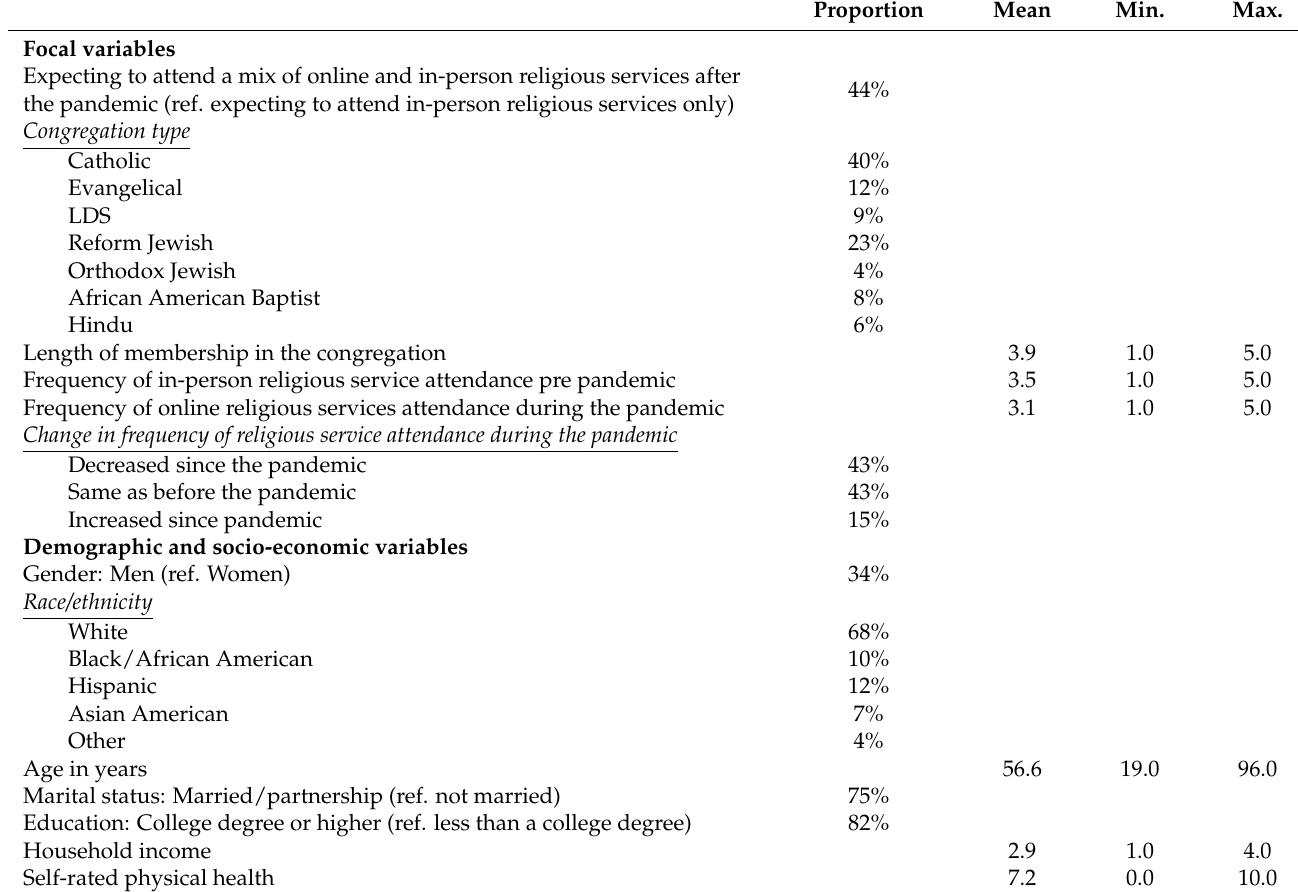
Table 1. Descriptive statistics of the analytic sample (n = 1116). Proportion Mean Min.